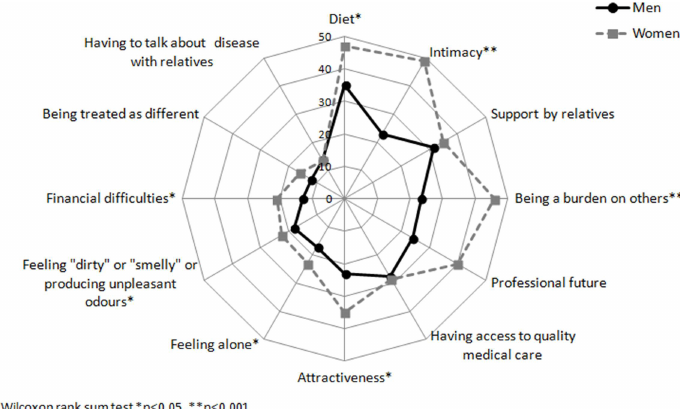
Fig 2. Median for individual concerns related to socialization and stigmatization according to gender.